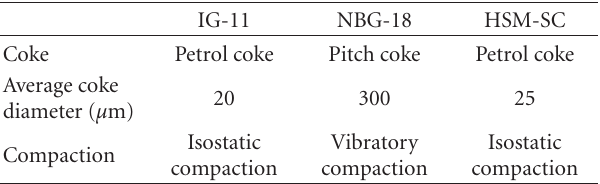
Table 1: Characteristics of three nuclear graphites chosen for the present study.